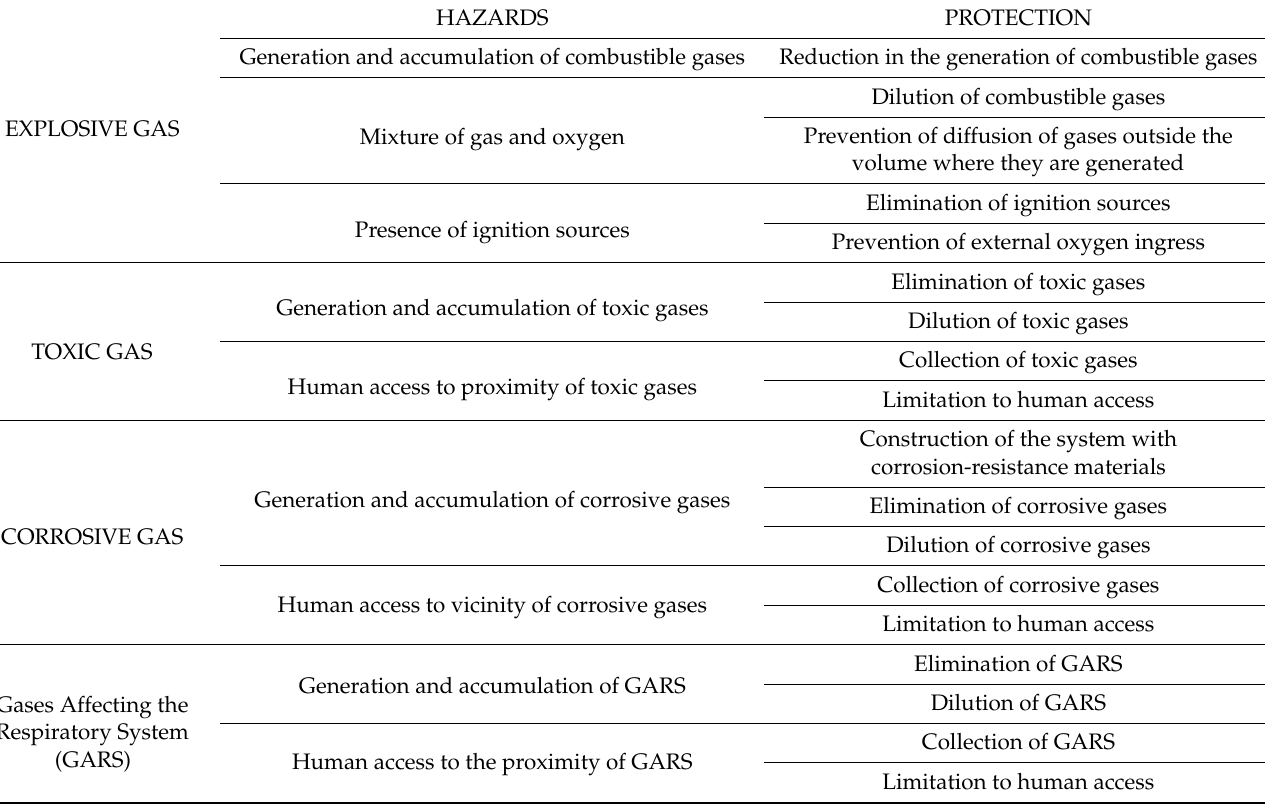
Table 1. Different risks associated with gases and a possible protective measure for